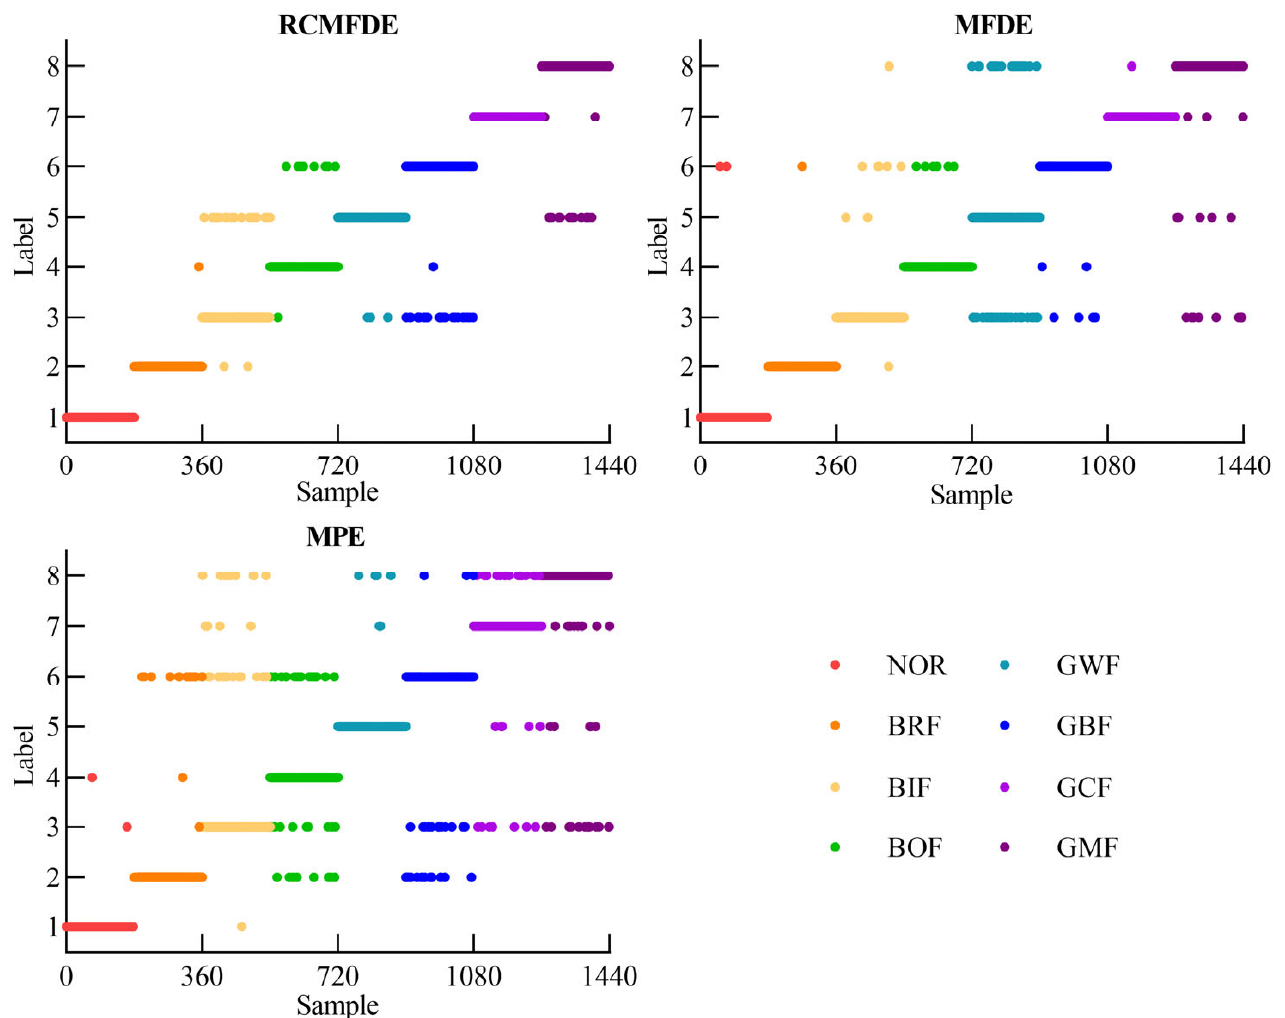
Figure 12. Recognition results of three feature sets.